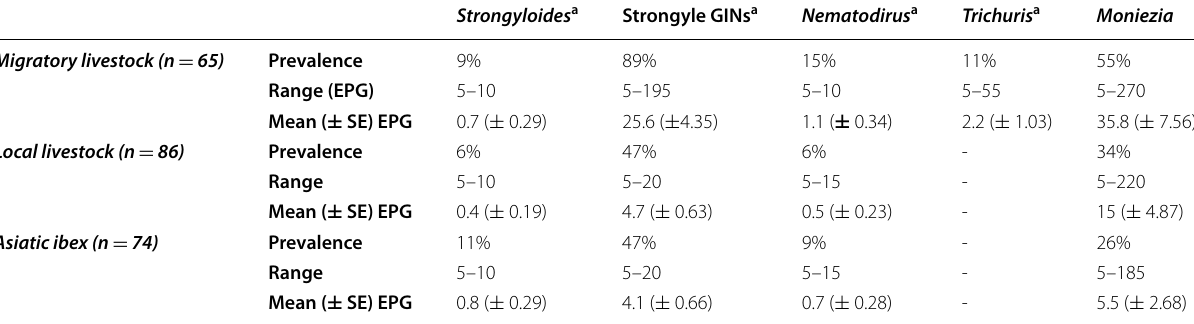
Table 2 Endo‑parasite prevalence, range (eggs per gramme) and mean ( standard error—eggs per gramme) across migratory ± livestock, local livestock and ibex. Sample sizes are number of pooled faecal samples, each representing a different host category: migratory livestock, local livestock and Asiatic Ibex. Prevalence is expressed at the level of the pooled sample and not the individual animal. Livestock comprise mixed groups of sheep and goats. Strongyles include eggs morphologically characteristic of the